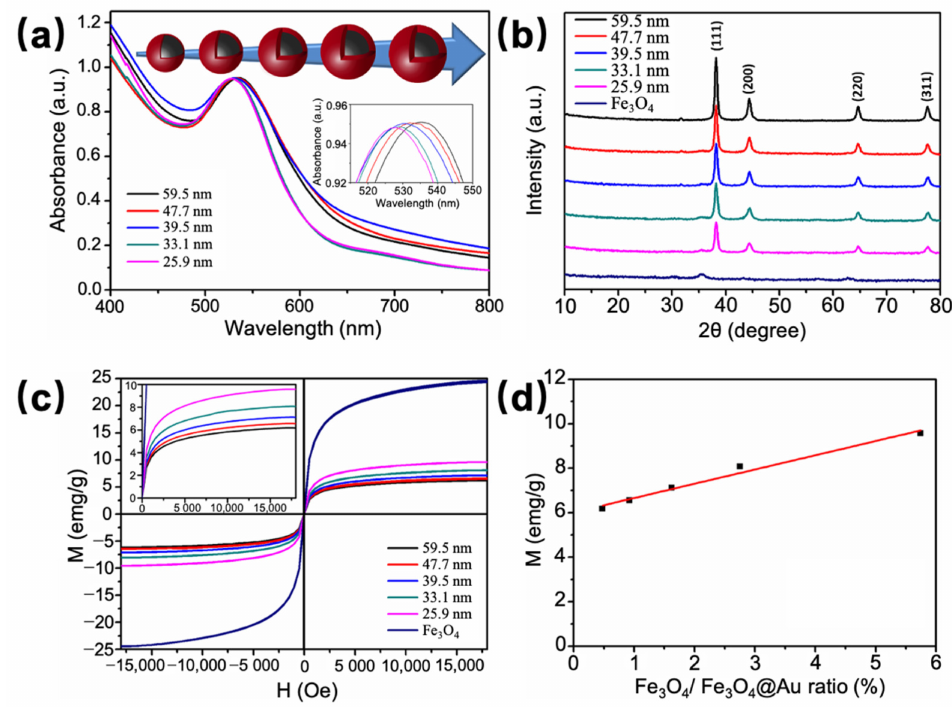
Figure 3. ( a ) UV-Vis spectra of different Fe 3 O 4 @Au NP sizes, the inset shows the difference of absorbance peak among each size of nanoparticles. ( b ) XRD patterns of different Fe 3 O 4 @Au NPs and Fe 3 O 4 NPs size distributions. ( c ) Magnetic hysteresis loops for the Fe 3 O 4 NPs and different Fe 3 O 4 @Au NP sizes. ( d ) The linear relationship between the saturation magnetization and the Fe 3 O 4 NP constitution